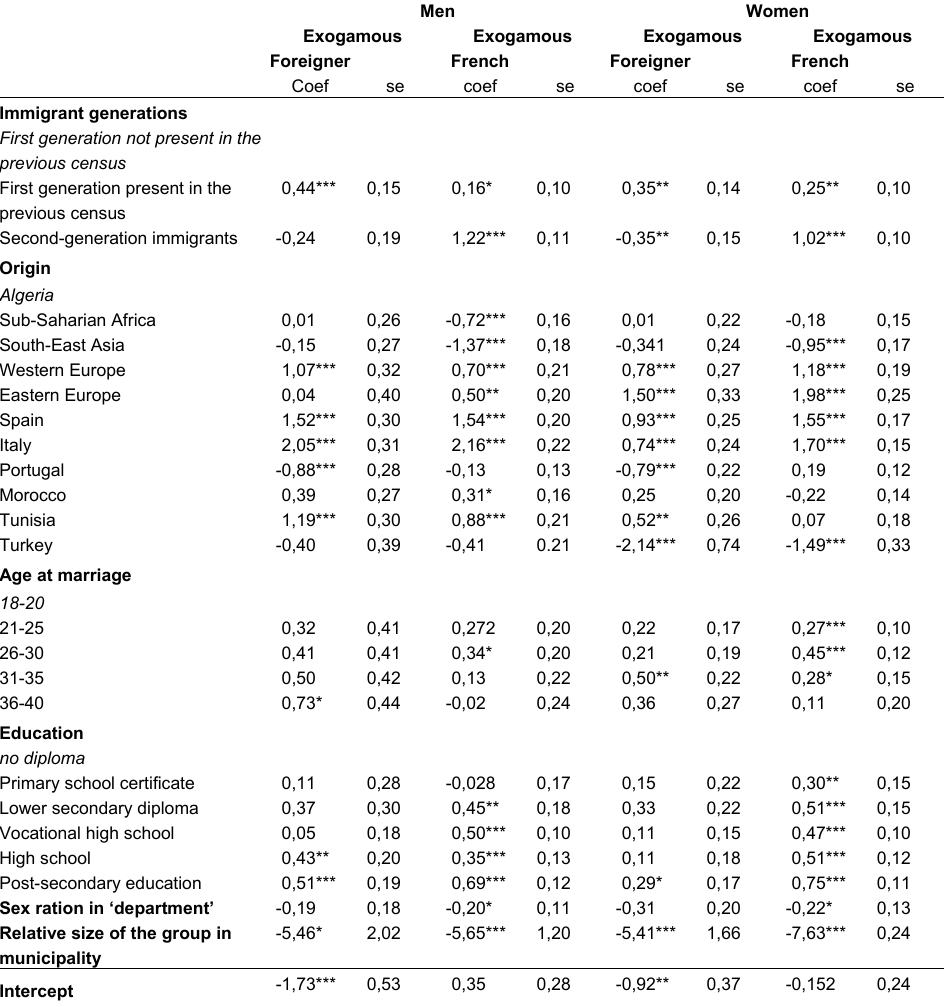
Table 4: Types of marriage for first- and second-generation immigrants (multinomial